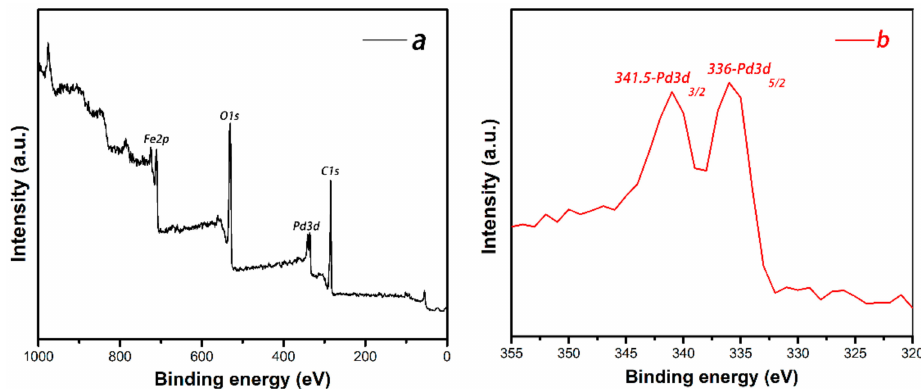
Figure 2. ( a ): XPS spectrum of Pd-Fe 3 O 4 . ( b ): XPS spectrum of Pd 0 in Fe 3 O 4